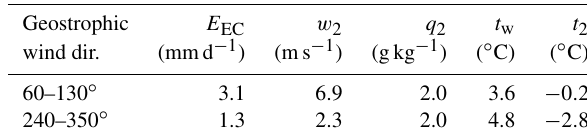
Table 5. The mean values of evaporation ( E EC ), wind speed ( w 2 ), air specific humidity ( q 2 ), lake surface temperature ( t w ), and air temperature ( t 2 ) calculated over the days when the geostrophic wind direction was 60–130 ◦ and when it was 240–350 ◦